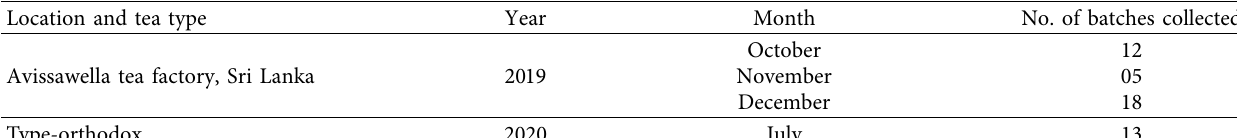
Table 2: Experiment details of fermentation cycles.